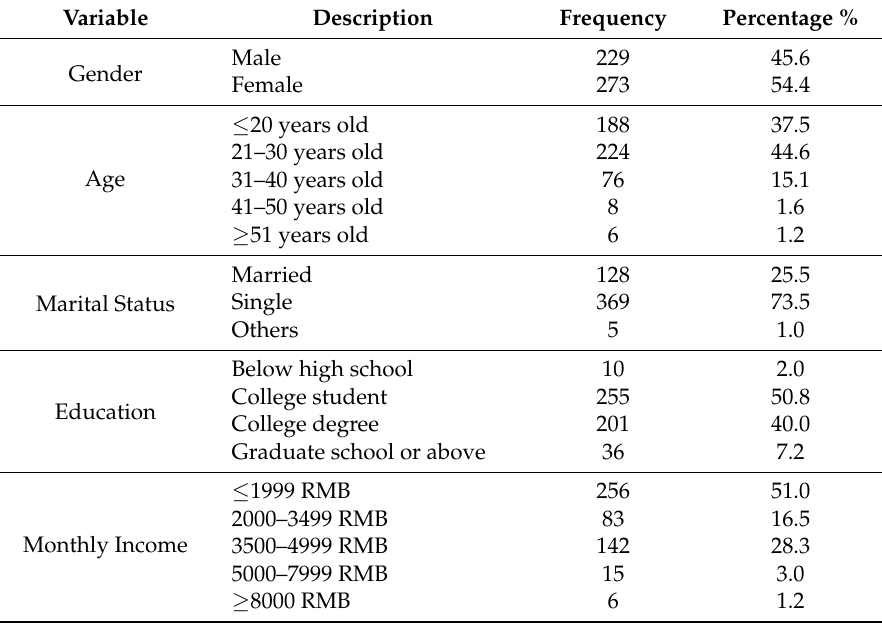
Table 1. Summary of respondents’ demographic characteristics.